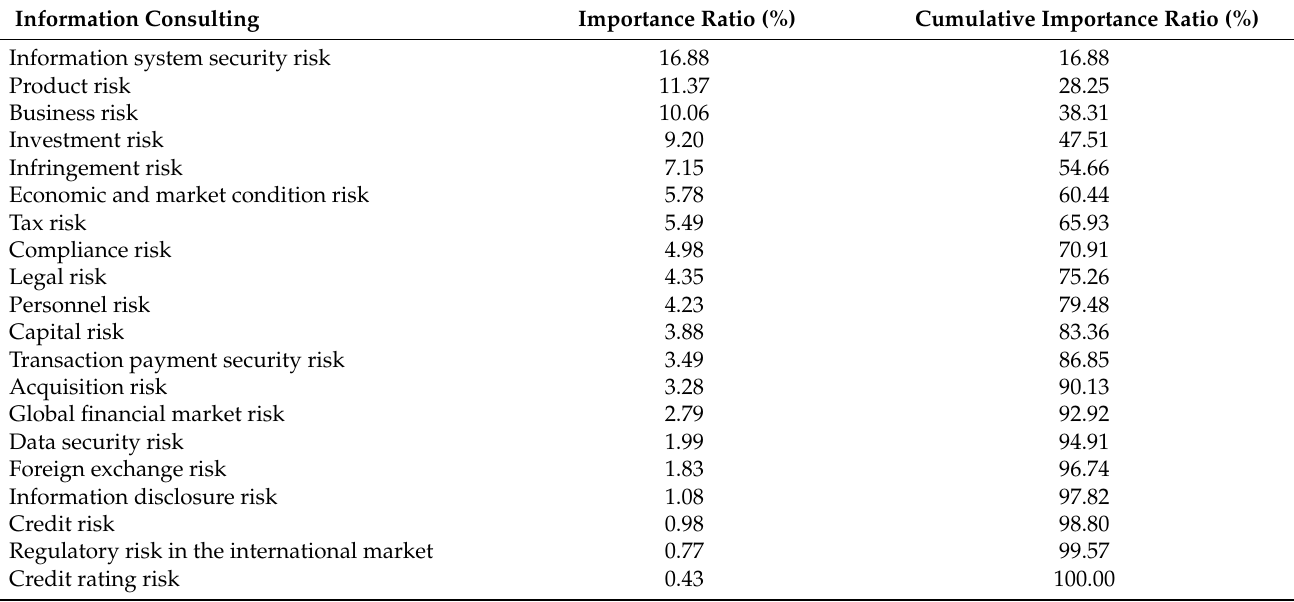
Table 6. The importance ratios of risks faced by the information consulting industry from 2015 to 2019.